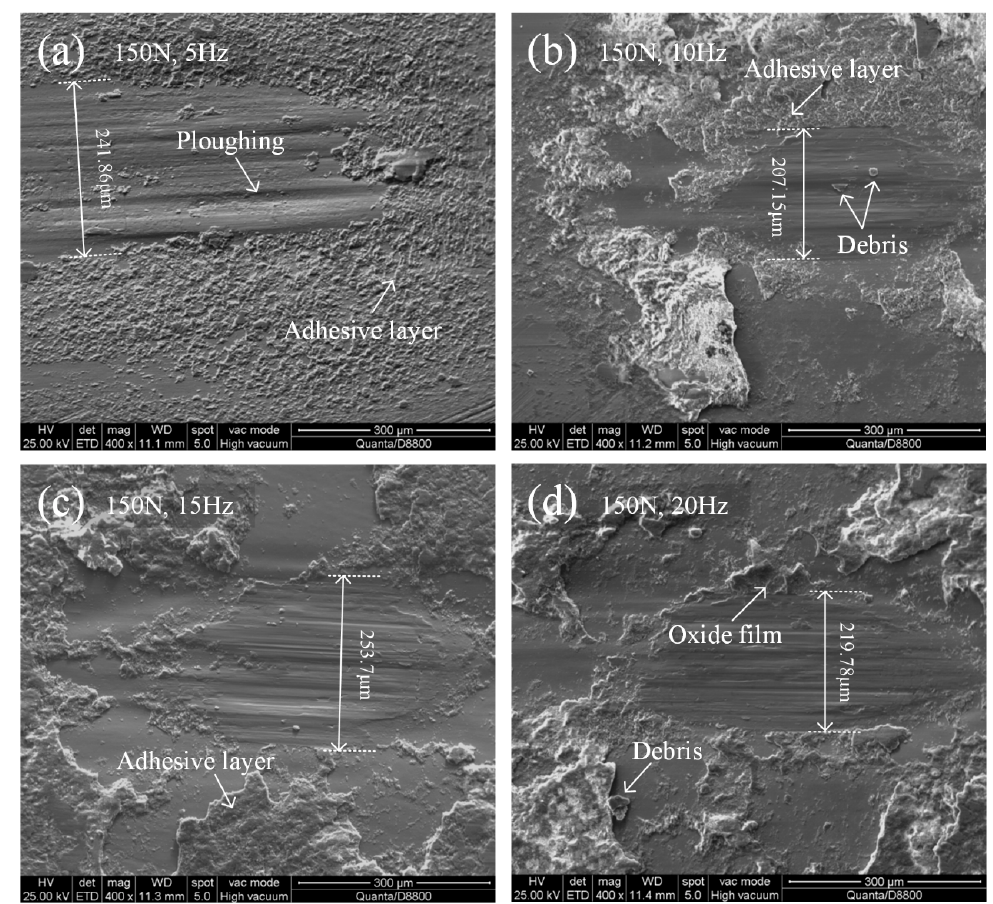
Figure 12. The surface worn SEM micrographs of specimen at frequencies of: ( a ) 5 Hz, ( b ) 10 Hz, ( c ) 15 Hz, and ( d ) 20 Hz.